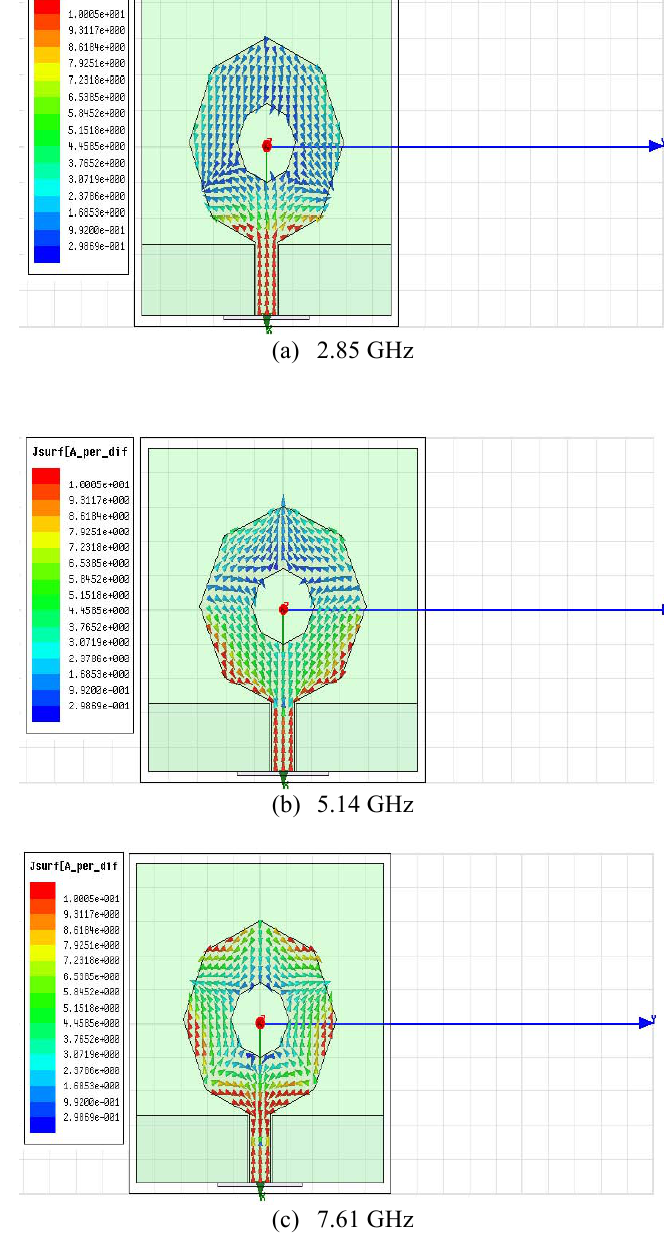
Figure 7: The surface current distribution of the proposed octagonal ring shape ultra wideband antenna at (a) 2.85GHz, (b) 5.14GHz, and (c)